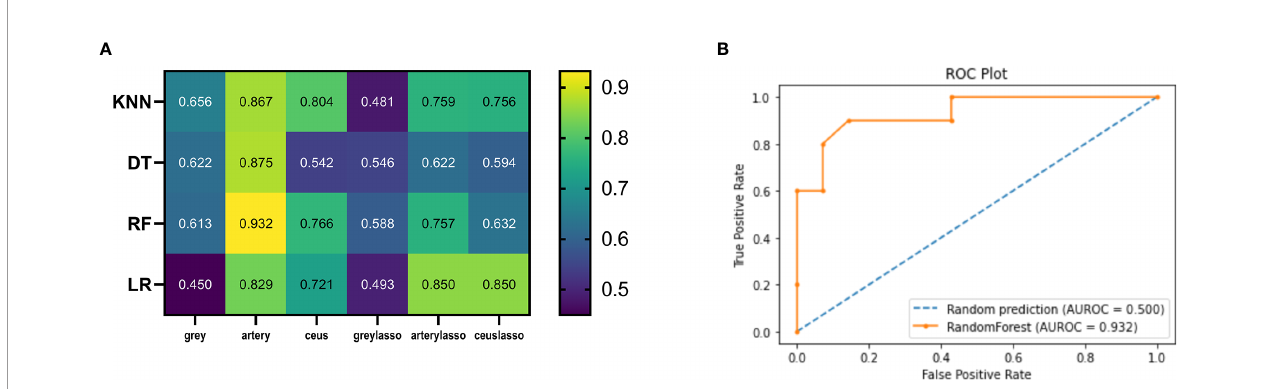
FIGURE 5 | Heatmaps illustrating the predictive performance (AUC) of different combinations of feature selection methods (rows) and classi fi cation algorithms (columns). (A) Cross-validated AUC values of 24 models on the training and validation datasets. (B) ROC curve of